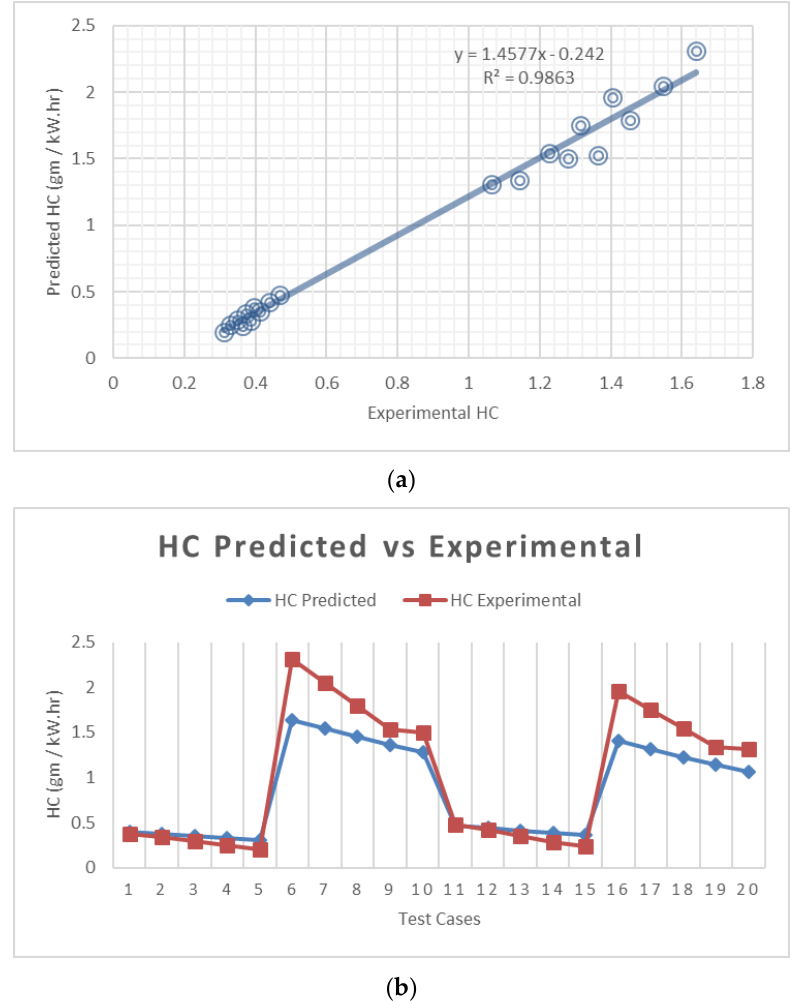
Figure 9. ( a ) Depiction of predicted and experimentally obtained HC values taken for 20 test cases; ( b ) Regression coefficient for the values predicted using ANN Vs experimental.